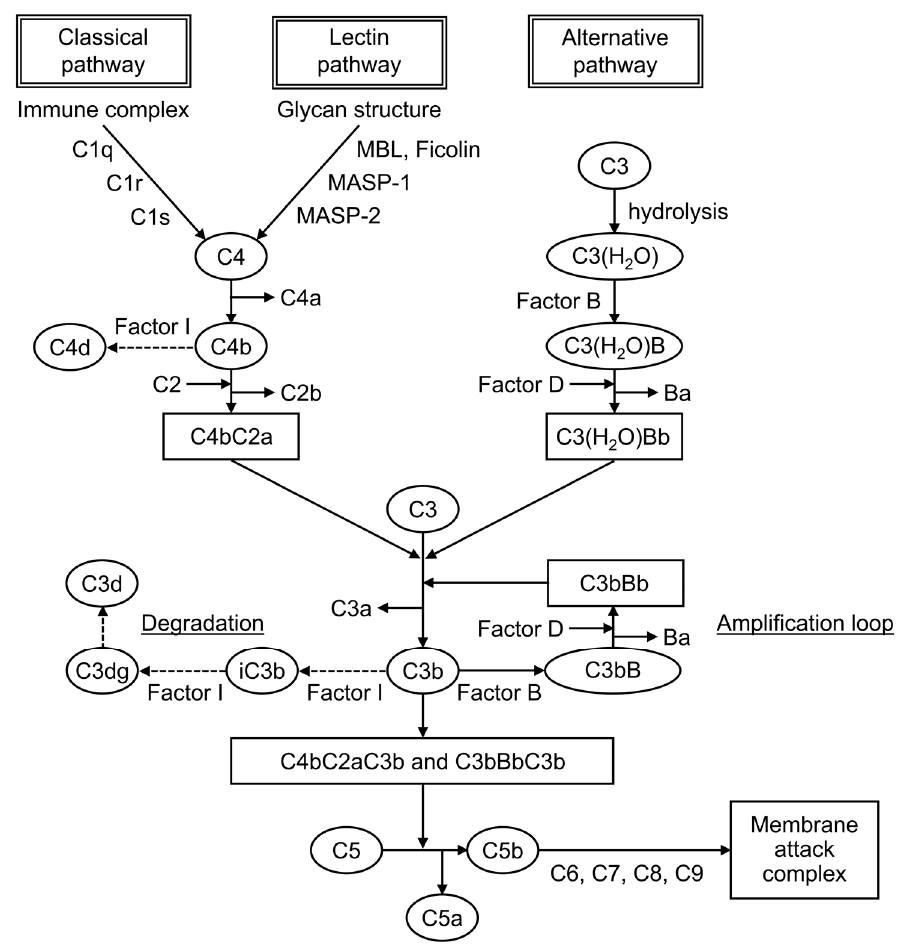
Figure 1. The complement cascade.